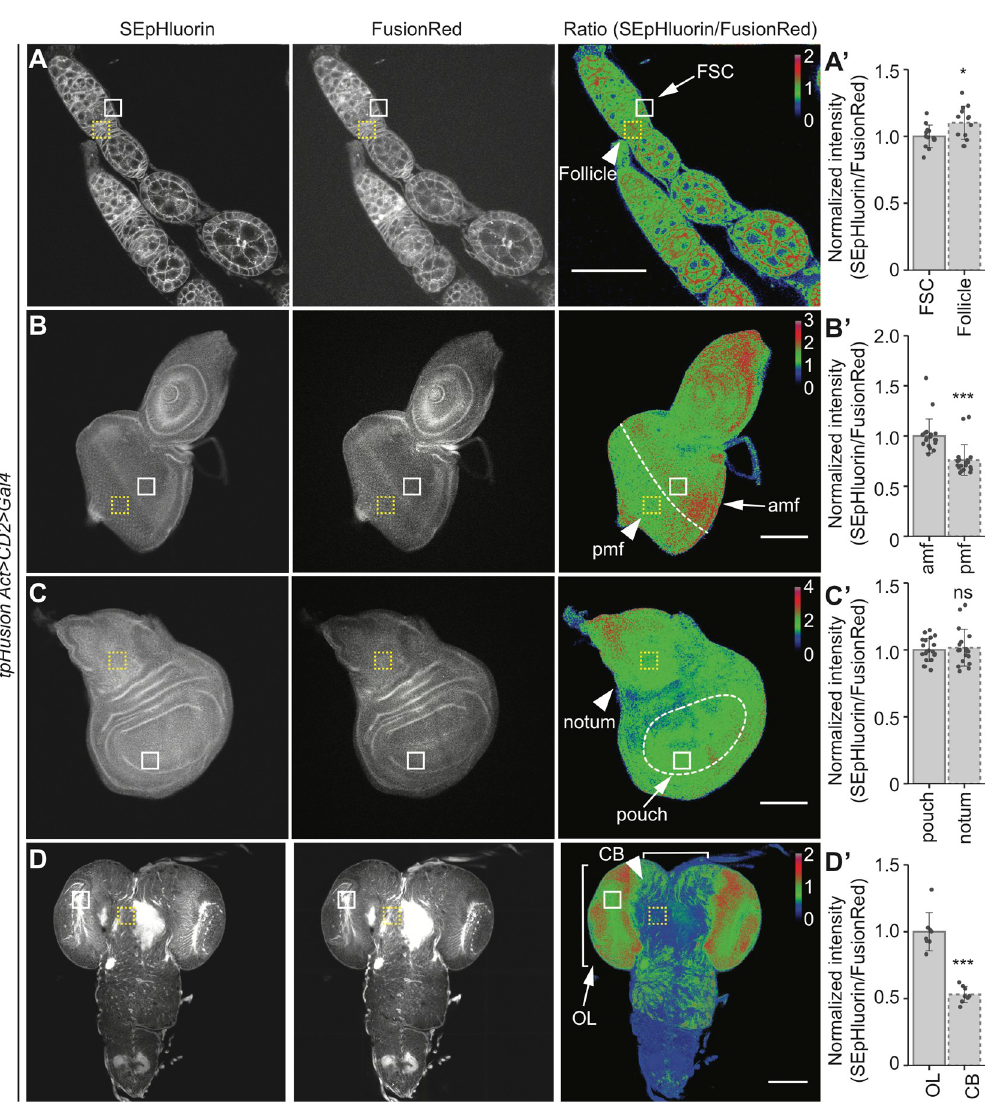
Fig 3. Comparison of pHi in different cell types of fixed tissues. (A-D) SEpHluorin, FusionRed, and ratiometric images of fixed (A) ovarioles, (B) eye discs, (C) wing discs, and (D) brains. (A’-D’) Quantification of the ratio of fluorescence intensities in (A’) FSC (arrow, white solid square) and follicle (arrowhead, yellow dashed square) cells, (B’) cells anterior (amf, arrow, white solid square) and posterior (pmf, arrowhead, yellow dashed square) to the morphogenetic furrow (dashed line), (C’) pouch (arrow, white solid square) and notum (arrowhead, yellow dashed square) cells, and (D’) cells in optic lobe (OL, arrow, white solid square) and central brain (CB, arrowhead, yellow dashed square). n > 7 larvae. Data are represented as mean ± standard deviation. � p < 0.05, ��� p < 0.001 and ns = not significant. Scale bar for A = 50 μ m, scale bar for B-D = 100 μ m. Calibration bar represents the ratio values of SEpHluorin to FusionRed intensities used to generate ratiometric